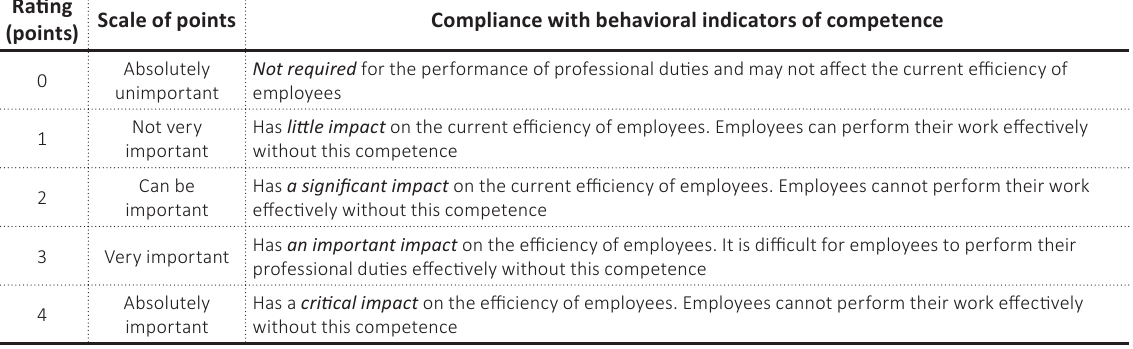
Source: Hair et al. (2019).